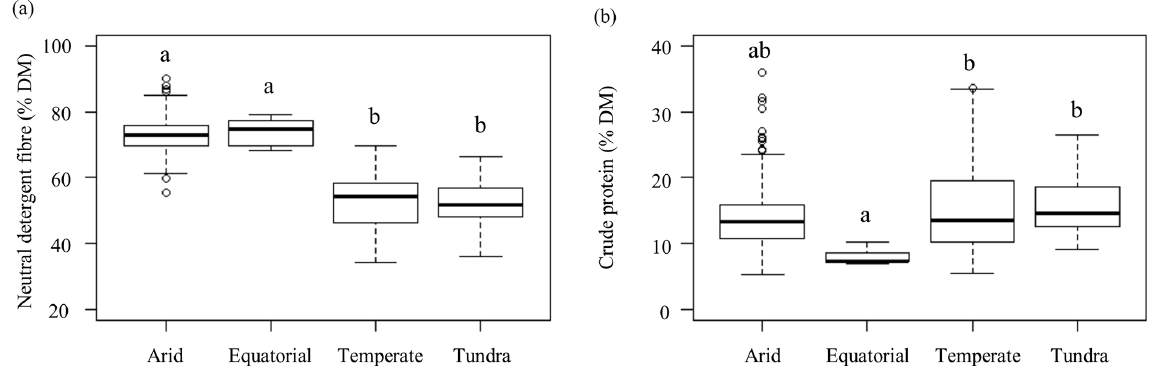
Figure 1. Box plots of (a) the neutral detergent fibre (NDF) and (b) the crude protein (CP) content of grasses located in bioclimatic zones as described by the Köppen–Geiger climate classification system. Significant differences between zones, as identified by the LME models, are denoted by different letters ( P< 0 . 05). Table 2. The minimum adequate linear mixed-effects models for forage-neutral detergent fibre (NDF) and crude protein (CP). The values represent slopes, except the C4 pathway values, which represent the absolute differences between the C3 pathway (intercept) and the C4 pathway. The site numbers differ between response types since temperature at the time of sampling and NDF and CP were not always available from all